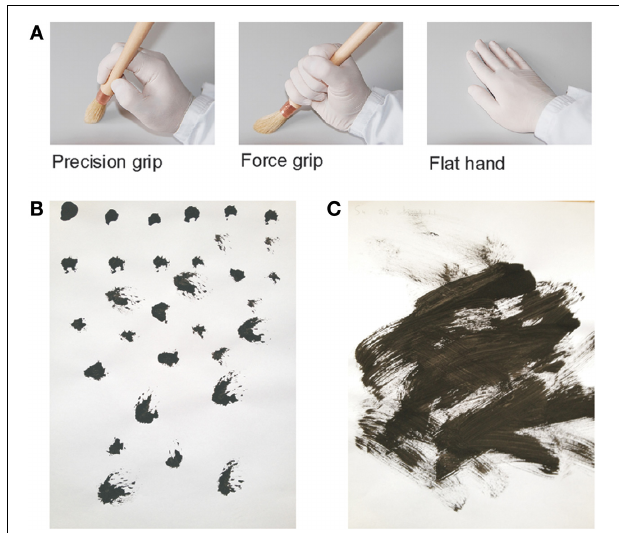
FIGURE 1 | Visuomotor training. During the associative training, three images (A) depicting a right gloved-hand holding a paintbrush with a precision or a power grip (or rested palm down as control) instructed the participants to produce pointillist-style (B) , and stroke-style (C) ,